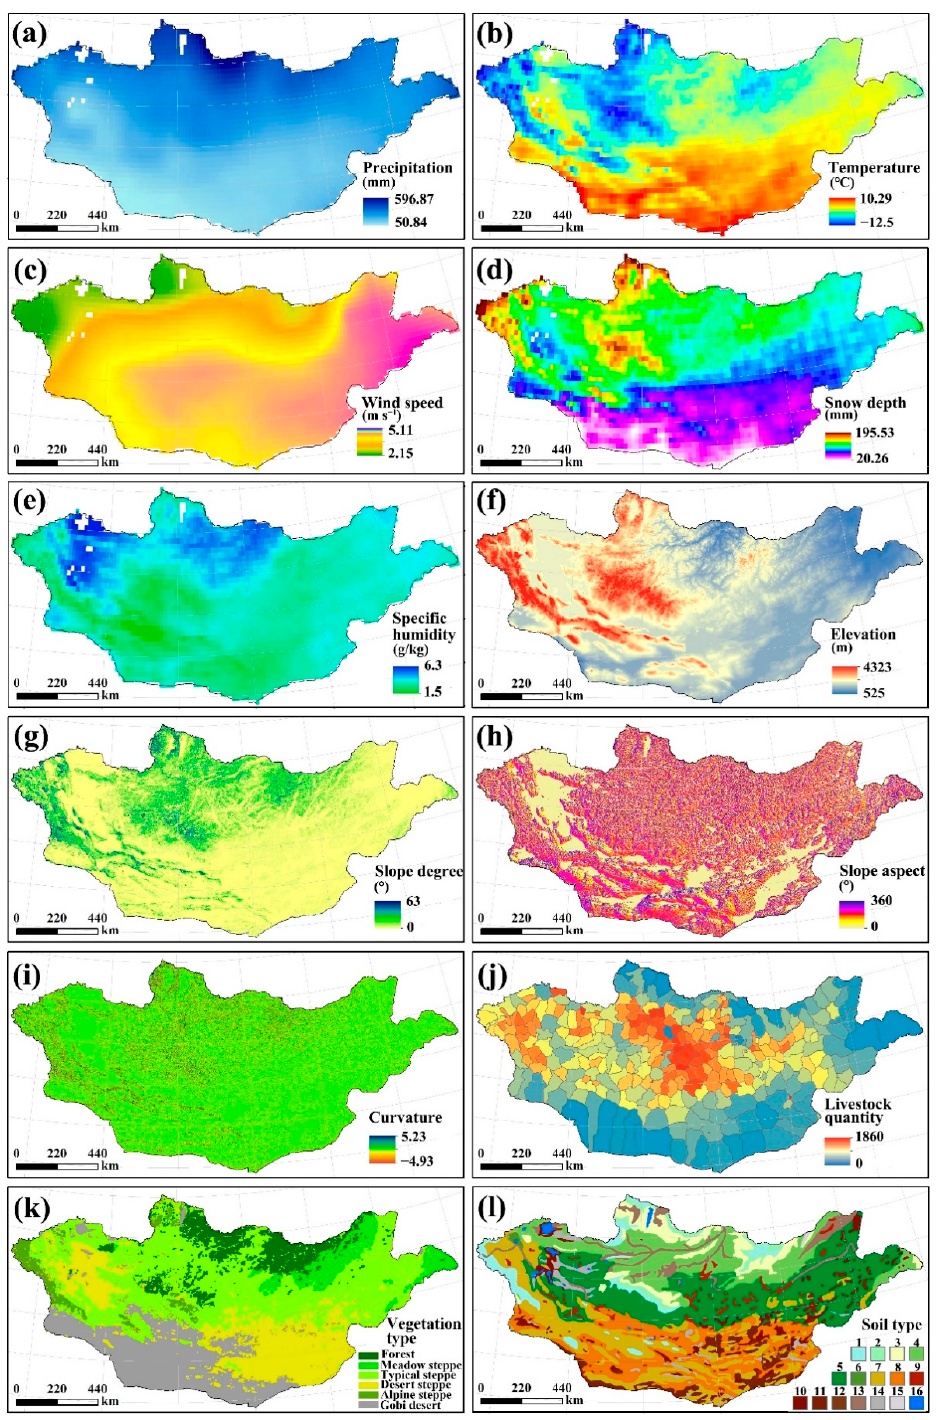
Figure 2. Maps of environmental factors: ( a ) annual average precipitation, ( b ) annual average temperature, ( c ) annual average wind speed, ( d ) annual average snow depth, ( e ) annual average specific humidity, ( f ) elevation, ( g ) slope degree, ( h ) slope aspect, ( i ) curvature, ( j ) livestock quantity (quantity of livestock per unit area), ( k ) vegetation type, and ( l ) soil type. The meanings of the serial numbers in the legend of soil type are (1) mountain meadow soil, (2) mountain peat soil, (3) grey forest soil, (4) dark chestnut soil, (5) chestnut soil, (6) chestnut soil and dark chestnut soil, (7) thin brown soil, (8) Gobi brown soil, (9) saline soil, (10) alkali and saline soil, (11) alkali soil, (12) cracked alkaline soil, (13) meadow soil and boggy soil, (14) sandy soil, (15) pine sandy soil, and (16) boggy soil.